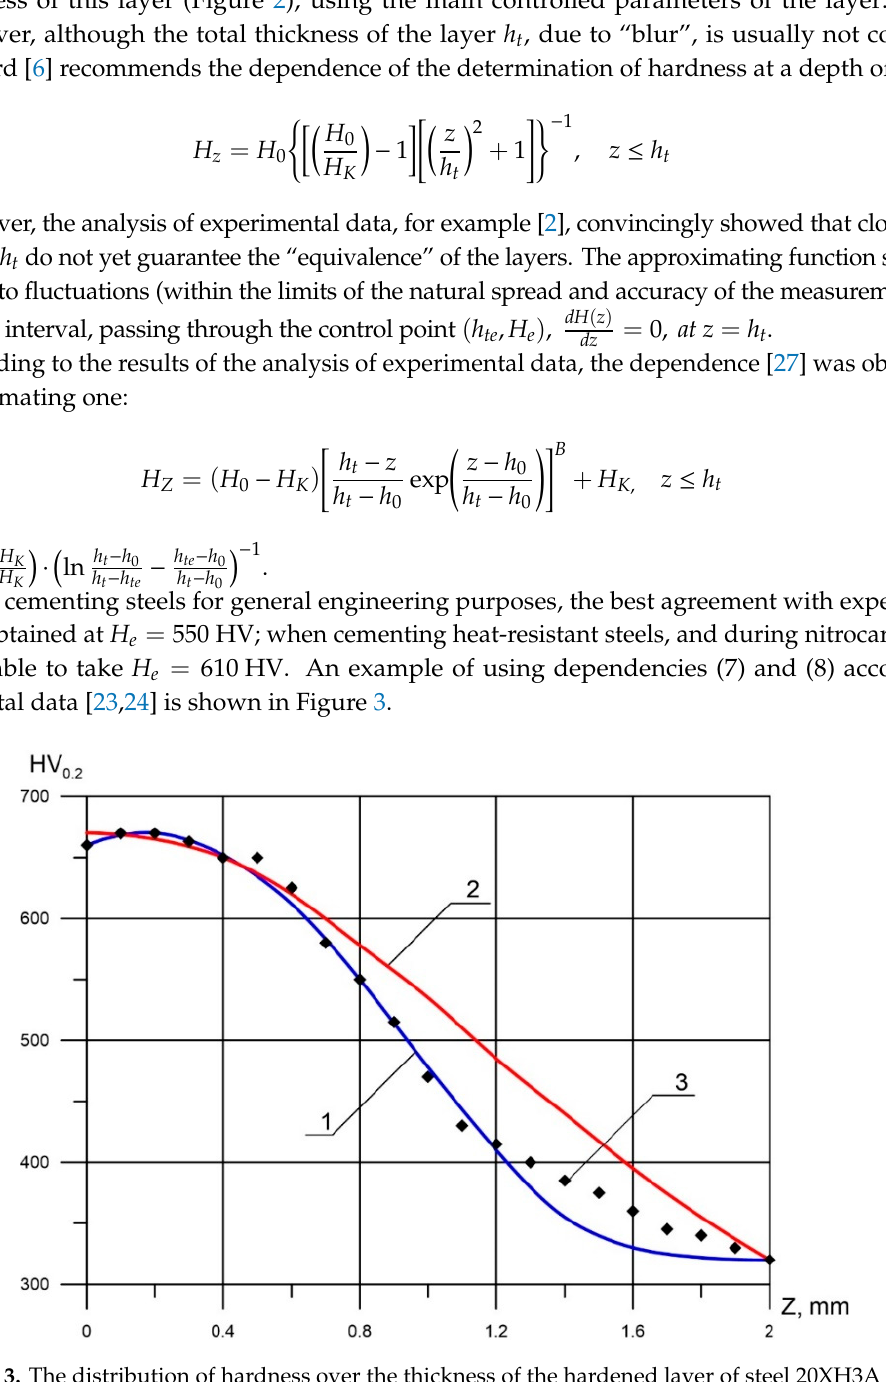
Figure 3. The distribution of hardness over the thickness of the hardened layer of steel 20XH3A after cementation. Layer options: H 0 = 680 HV; H K ≈ 320 HV; h 0 = 0.1 mm; h te = 0.8 mm; h t ≈ 2.0 mm. 1—distribution according to (8); 2—according to (7); 3—experimental data. Novikov’s nitro-cemented gears were bench tested at the IzMSK Ltd. company (Izhevsk, Russia) [27]. Although all the samples were made of steel of the same batch, and they passed CCT simultaneously, the dispersion of hardness values reached 150 HV within one tooth and 250 HV for the same points